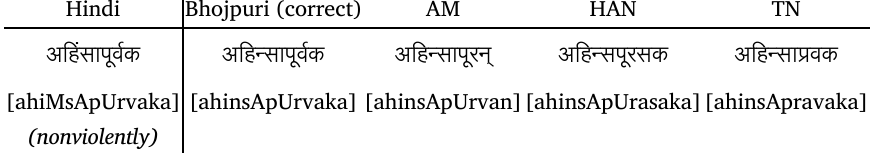
Table 10: Handling the diacritic for र् [a] Hindi Bhojpuri